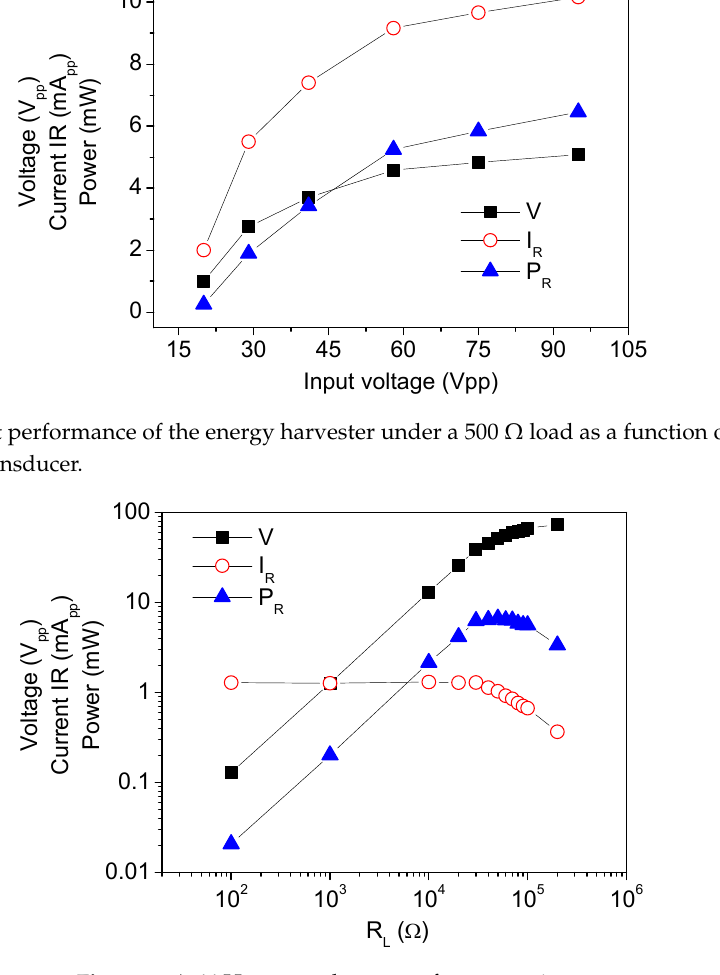
Figure 9. A 66 Hz energy harvester for comparison. Table 1. Performance parameters of the high and low frequency energy harvesters.